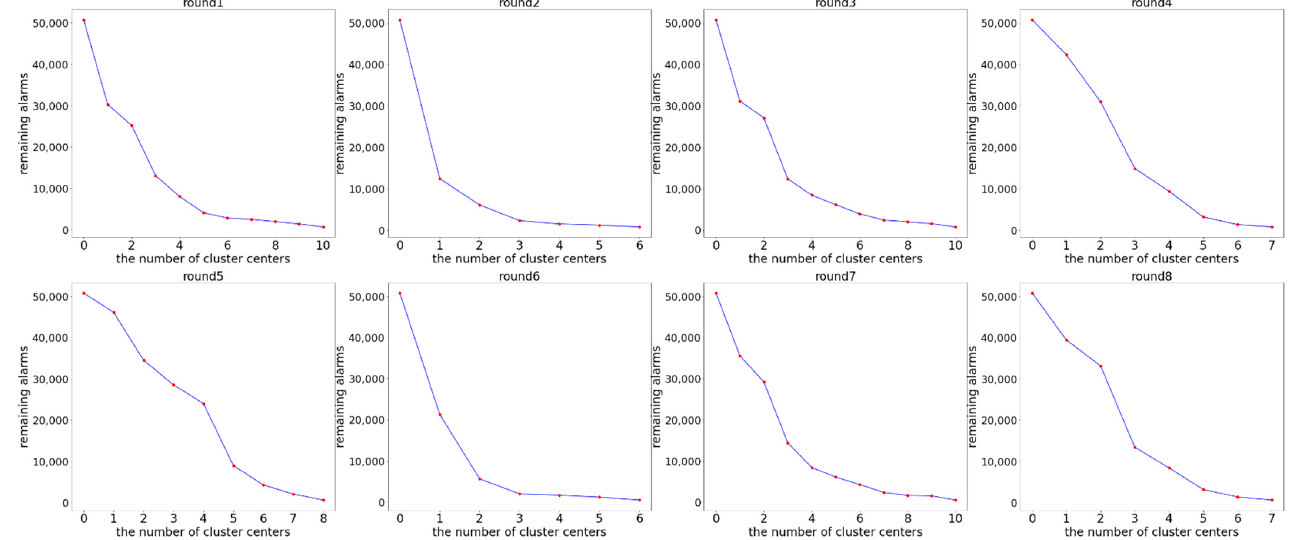
Figure 18. Comparison of the final results of eight experiments